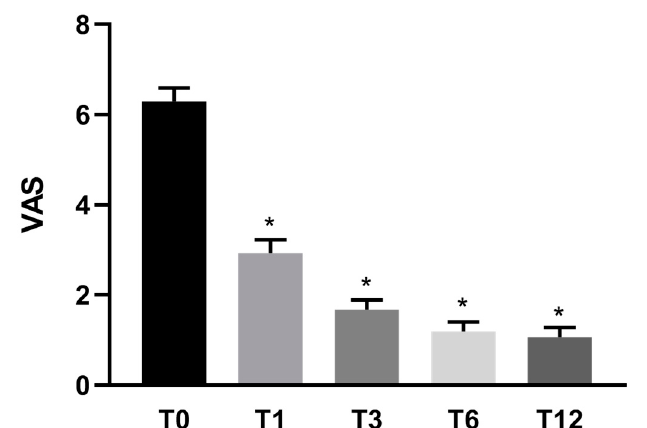
Figure 1. Mean VAS score ( n = 30) before and after Lipocell treatment. T0 is pre-treatment, Tx is x months after the treatment. Error bars show SEM * p vs. pre-treatment <0.01.